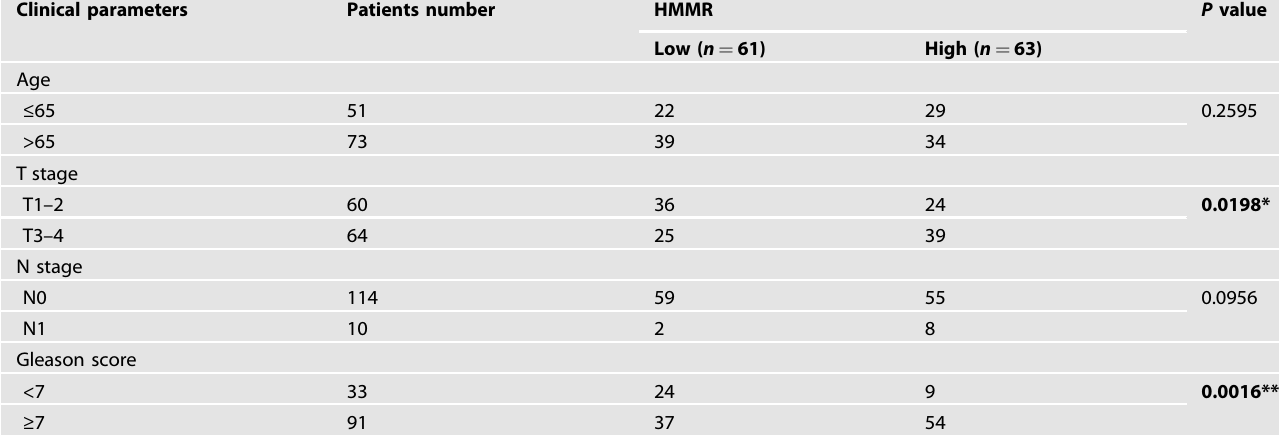
Table 1. Association between HMMR expression level and clinicopathological characteristics in 124 cases of PCa. Clinical